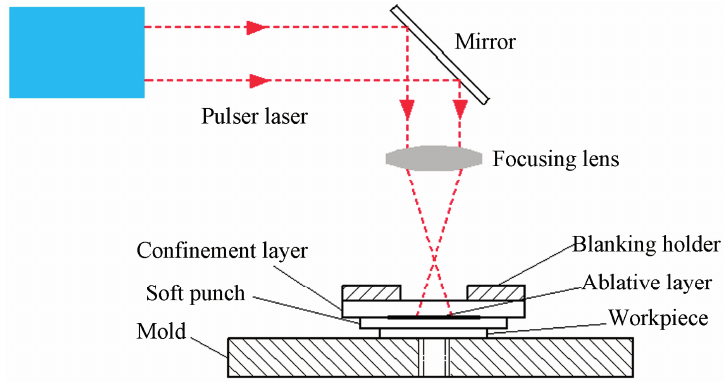
Figure 1. Schematic of the laser shock punching process.